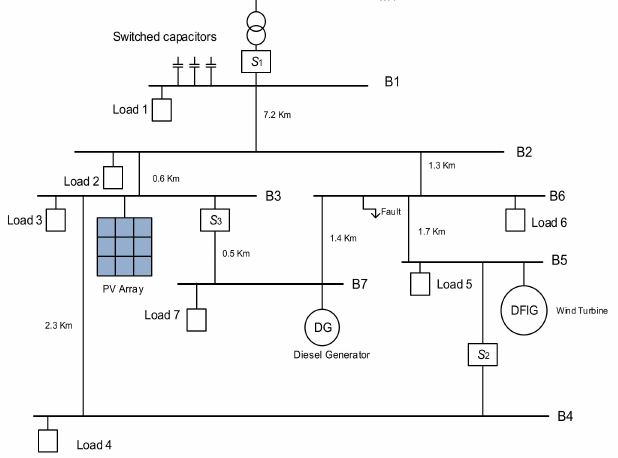
Figure 1. The distributed energy resources (DER)-based microgrid